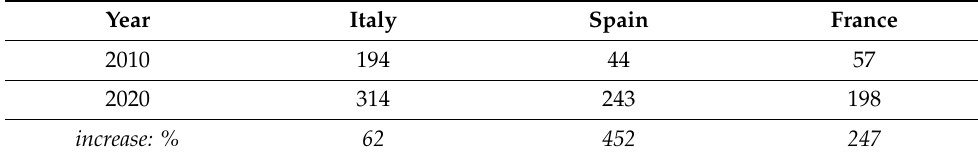
Table 1. An example showing that the frequency of harsh hydrological events (here just “heavy rains” and “avalanches”) is in general growing (https://www.eswd.eu/, accessed on 11 October 2021). Year Italy Spain